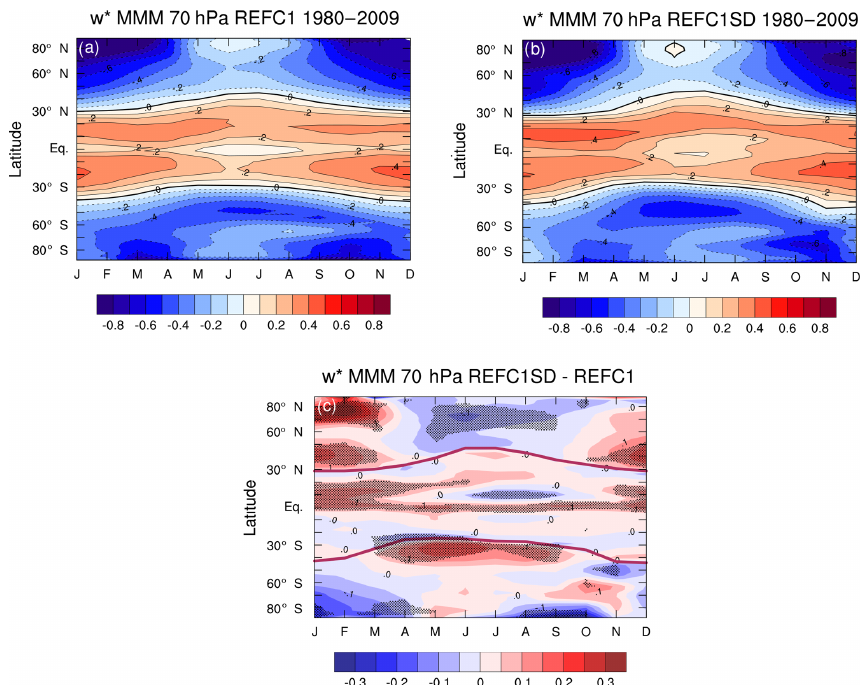
Figure 6. Climatological MMM annual cycle in w ∗ (mms − 1 ) at 70hPa for (a) REF-C1, (b) REF-C1SD, and (c) the REF-C1SD minus REF-C1 absolute differences. The shading in (c) denotes regions where the differences are statistically significant above 95% using a two- tailed Student’s t test. The turnaround latitudes ( w ∗ = 0) are shown by the thick black lines in (a) and (b) and by the thick red lines for the REF-C1SD MMM in (c)